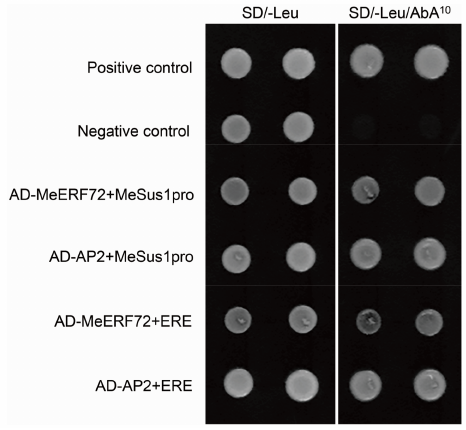
Figure 3. ERF72 protein/AP2 domain can bind to MeSus1 promoter and its ethylene responsive element (ERE). Yeast cells that carried AD-53+p53-AbA (Positive control), AD-53+pAbAi (Negative control), AD-MeERF72+MeSus1pro-AbA, AD-AP2+MeSus1pro-AbA, AD-MeERF72+pERE-AbA and AD-AP2+pERE-AbA were grown in SD/-Leu selective medium containing 10 ng/mL AbA for three days at 30 ◦